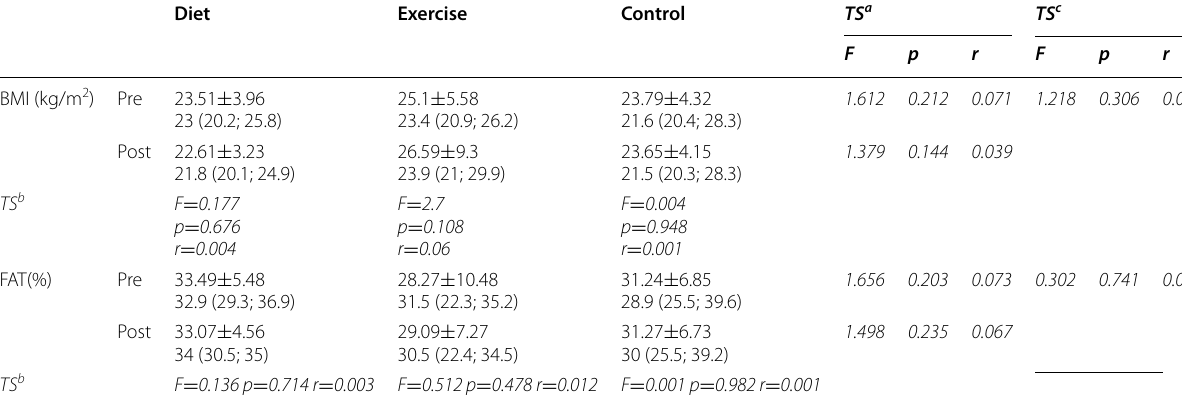
TS test statistics, pre first measurement, post last measurement, F two-way analysis of variance in repeated measures, r effect size. a Comparison between groups, b intra-group comparison, c comparison of pre and post values between groups, summary statistics mean standard deviation; given as median (first quartile–third ± quartile) values of time on BMI and FAT% was not significant in all groups ( p ˃ 0.05). No significant difference was found in the BMI and FAT% before and after treatment in all The demographic data of participants are presented in groups ( p ˃ 0.05). The BMI and FAT% were expressed Table 1. The mean age of participants in DG was 21.6 in kilogramme/metre 2 (kg/m 2 ) and percentage (%), 1.64 years, 19.6 0.99 years in EG and 21.53 2.03 ± ± ± respectively. years in CG. Before and after treatment, the main effect